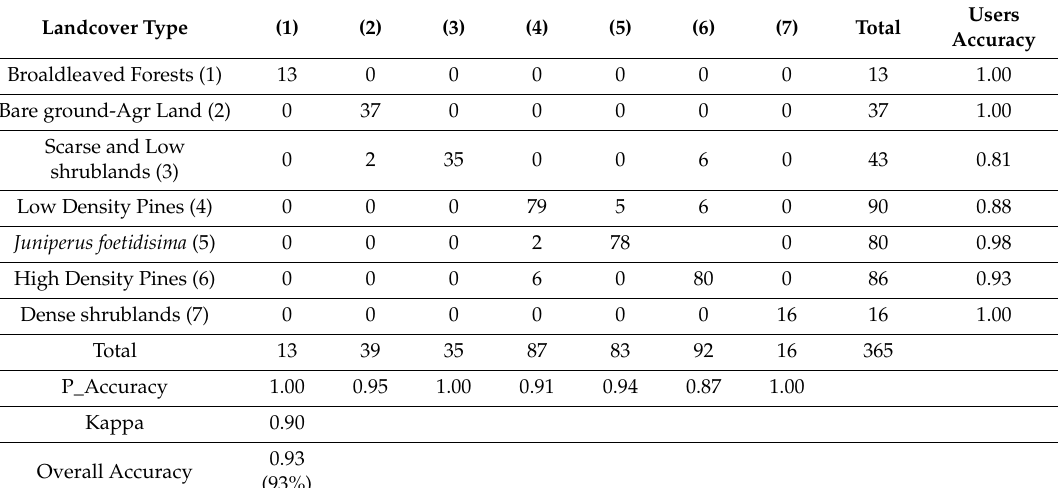
Table A1. Confusion Matrix and accuracy assessment of the landcover